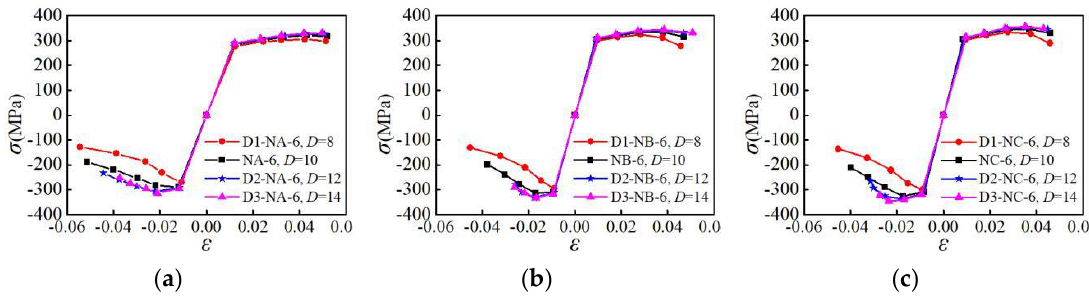
Figure 17. Influence of parallel section diameter on skeleton curves: ( a ) group A of specimens; ( b ) group B of specimens; ( c ) group C of specimens.